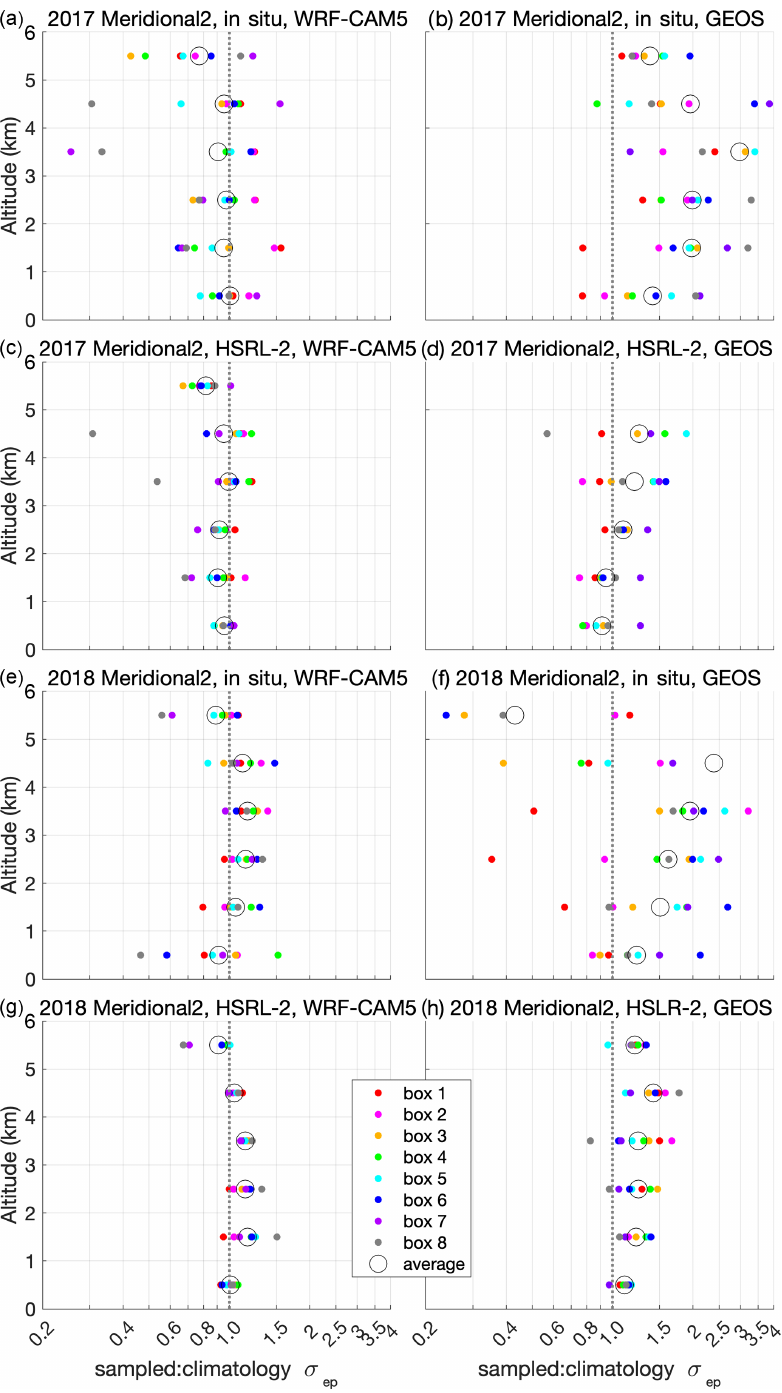
Figure 4. As in Fig. 3 but showing the representativeness of sampled σ ep values to the month-long average of σ ep across the 2017 merid- ional 2 and 2018 meridional 2